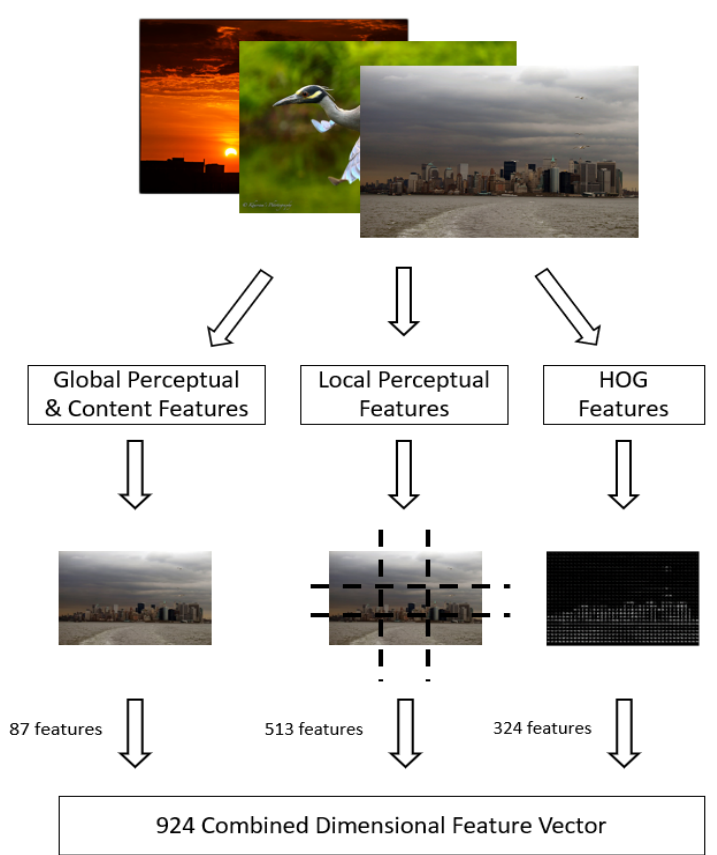
Figure 3. The categorization and count of features extracted for each